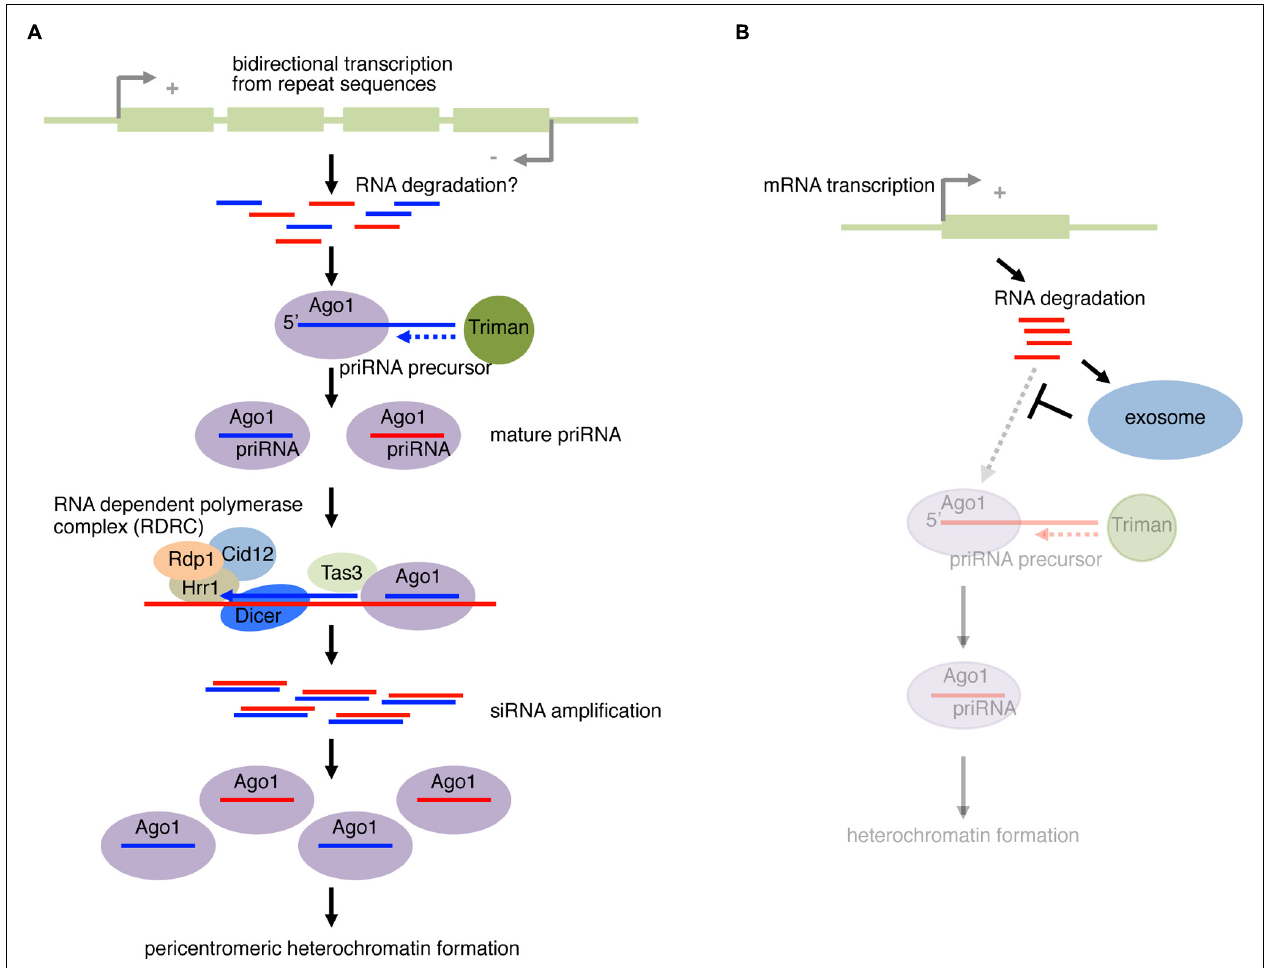
and Cid12. Dicer cleaves the dsRNA to form siRNA. The siRNA can be loaded to Ago1 that continues the positive feedback cycle.